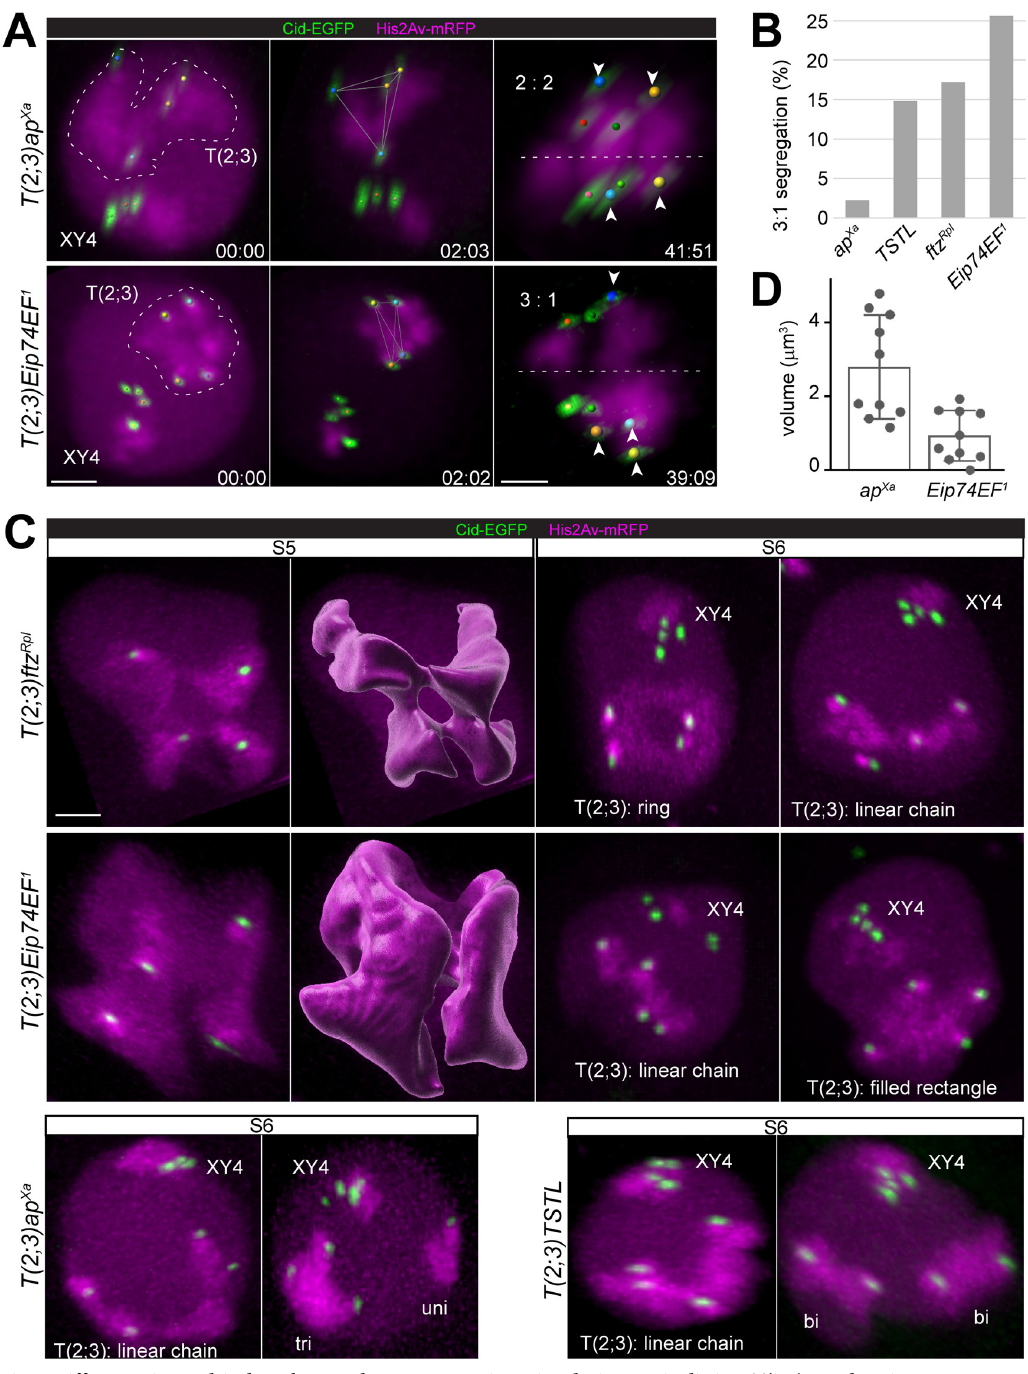
Fig 4. Differences in quadrivalent shape and centromere orientation during M I in distinct T(2;3) translocations. Spermatocytes heterozygous for the indicated reciprocal T(2;3) translocations were analyzed by time lapse imaging using His2Av- mRFP and Cenp-A/Cid-EGFP as markers. ( A ) Still frames illustrate progression from onset NEBD I until end of metaphase I. The territories formed by the quadrivalent [T(2;3)] and by the other chromosomes (XY4) are indicated in the first frame. Tracked centromeres are marked by spheres with colors indicating the associated chrX and chrY (red), chr4 (green), chr2 and chr3 (yellow and blue). The equatorial plane (dashed lines in the last frame) reveals the segregation pattern of the four quadrivalent centromeres (arrowheads, larger spheres) as 2:2 (A, top) or 3:1 (A, bottom). Time (min:sec) relative to onset NEBD I. ( B ) Bars represent the frequency of 3:1 segregation of the quadrivalent during M I in spermatocytes heterozygous for the indicated T(2;3) translocations. n = 44 ( ap Xa ), 54 ( TSTL ), 58 ( ftz Rpl ) and 86 ( Eip74EF 1 ) spermatocytes from at least seven distinct cysts. ( C )